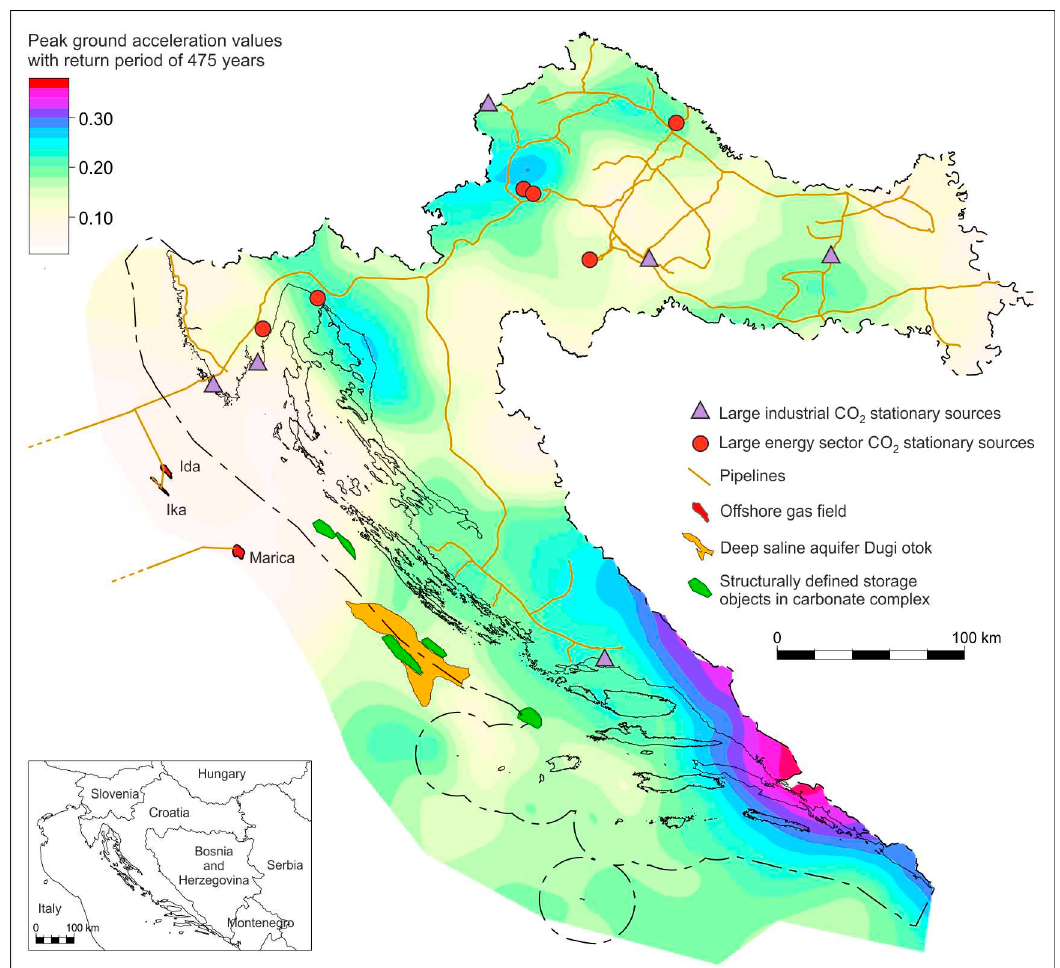
Figure 1. Location map of large stationary CO 2 sources (Croatian Environmental Pollution Register [3]), main pipeline network (after [4,5]), contours of the potential CO 2 geological storage objects in the Adriatic offshore and the peak ground acceleration values with a return period of 475 years (after [6]).